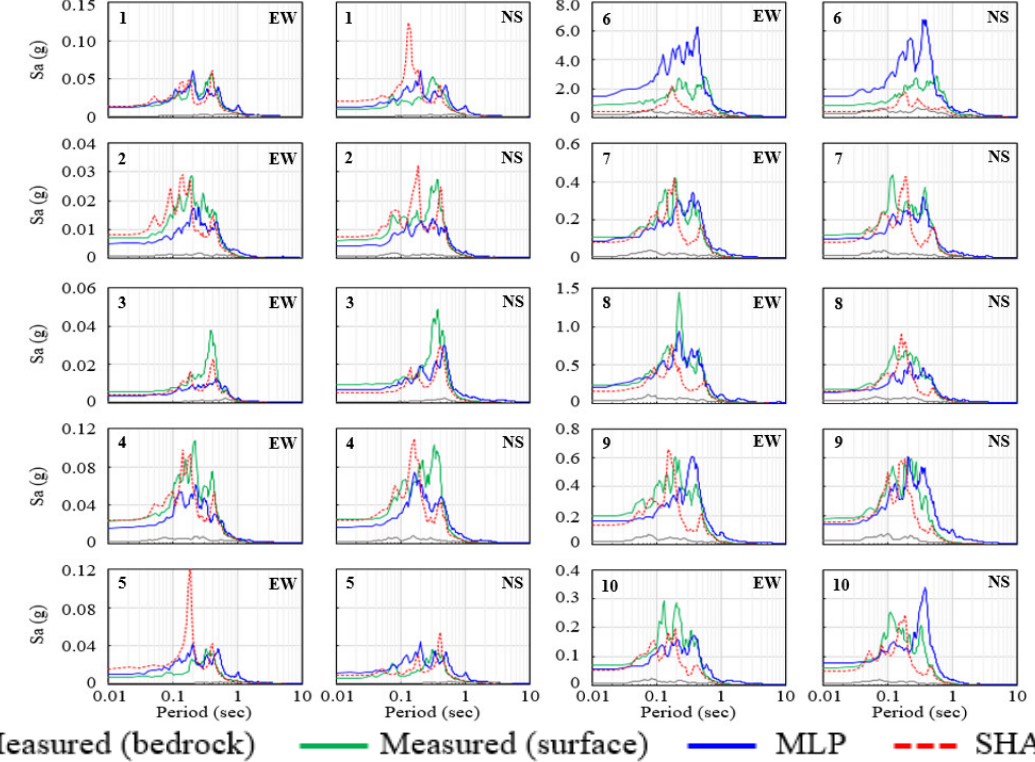
Figure 9. Measured, predicted, and computed response spectra at IBRH11 for east–west and north–south directions.